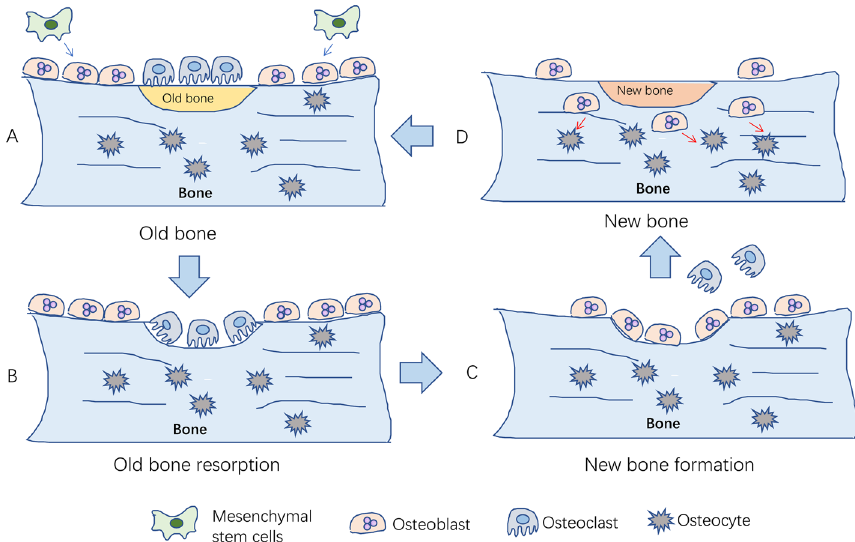
Fig. 1 The process of bone remodeling under physiological conditions. A Local bone degenerates into old bone. Mesenchymal stem cells differentiate into osteoblasts; B osteoclasts migrate to the surface of old bone for bone resorption; C osteoclasts leave the surface after the old bone is absorbed, and then osteoblasts migrate to the surface for bone formation; D new bone replaces old bone to maintain bone quality, strength, and mass. After bone formation, osteoblasts differentiate into